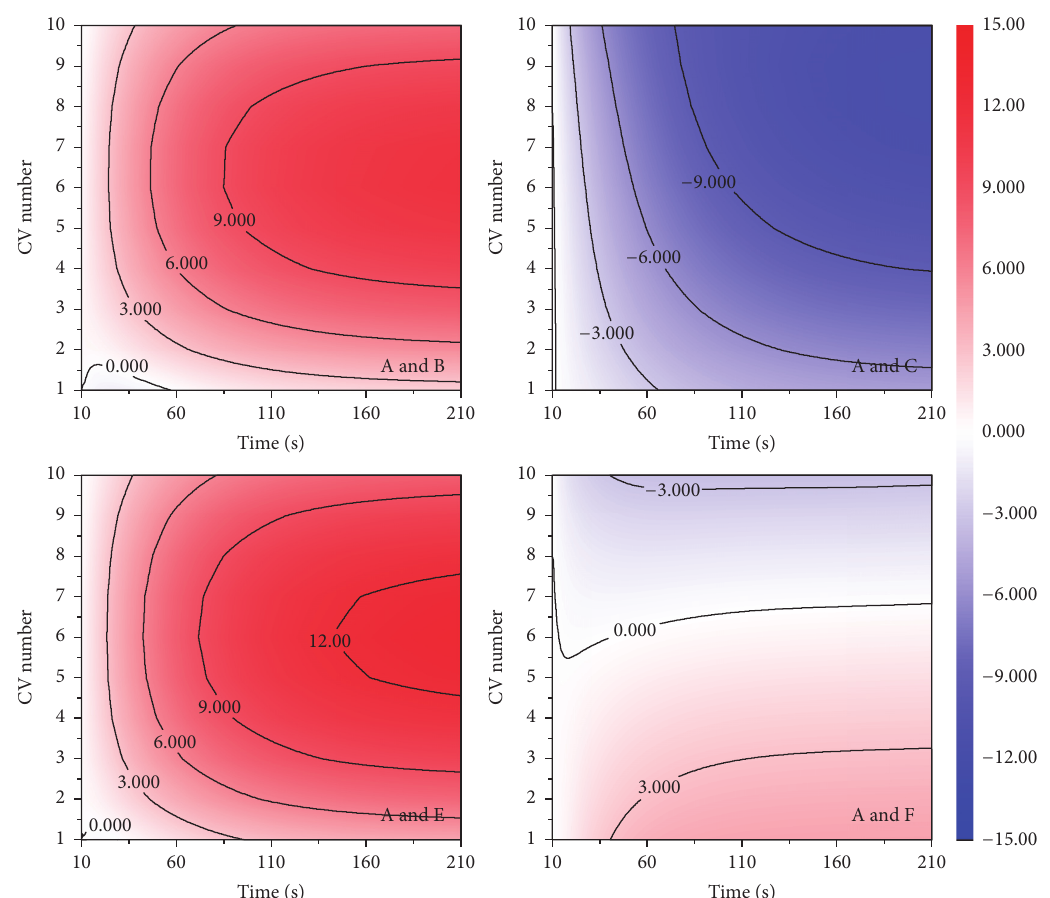
Figure 9: Recuperator core temperature responses to dual bypass valves.